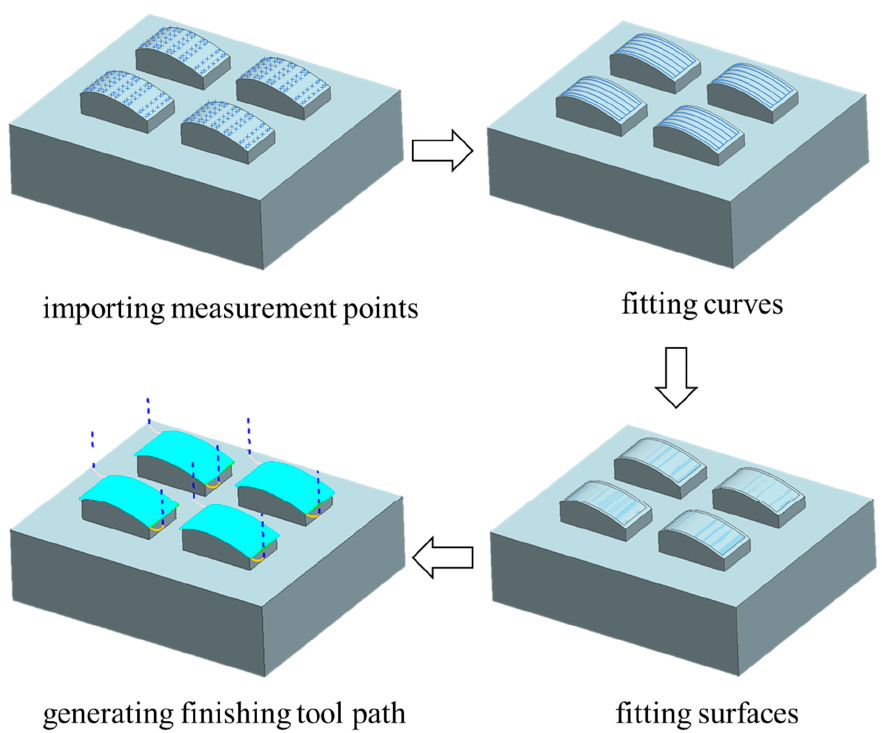
Figure 8. Automatic compensation flow for free-form surfaces.